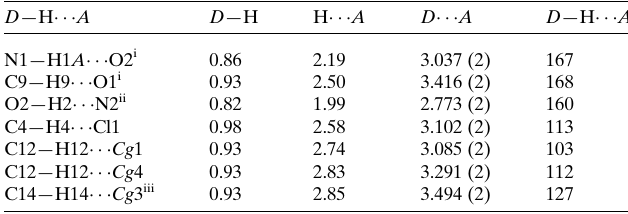
Table 1 Hydrogen-bond geometry (A˚ , (cid:2) ).